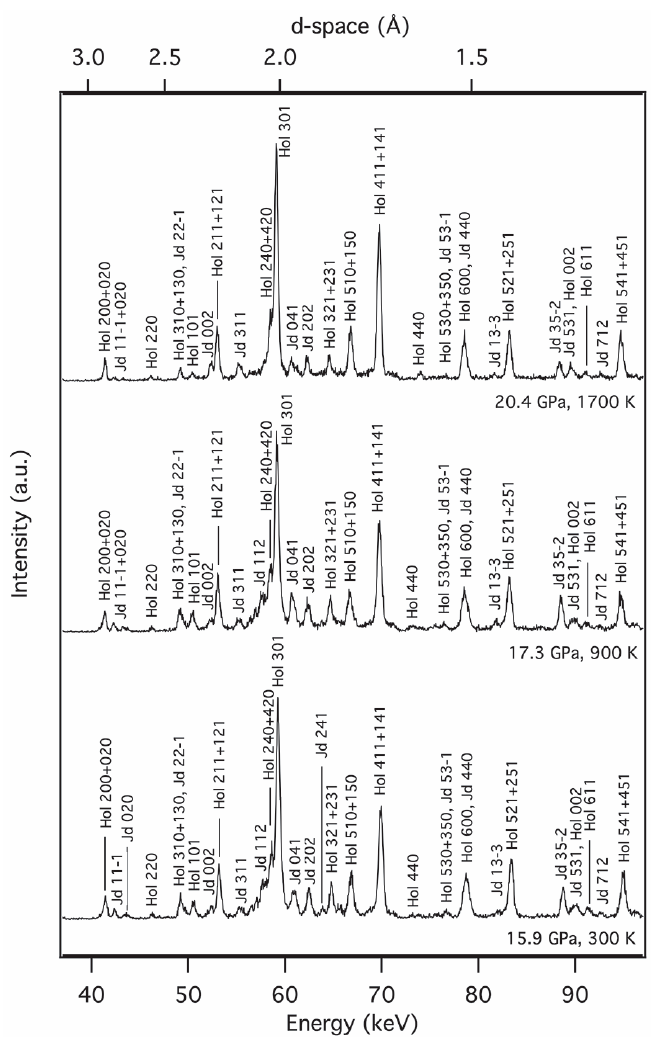
Figure 2. X-ray diffraction pattern of the microcline aggregate at high pressure and high temperature. Abbreviations: Hol, Na-rich liebermannite; Jd, jadeite. Abbreviations: Hol, Na-rich liebermannite; Jd,